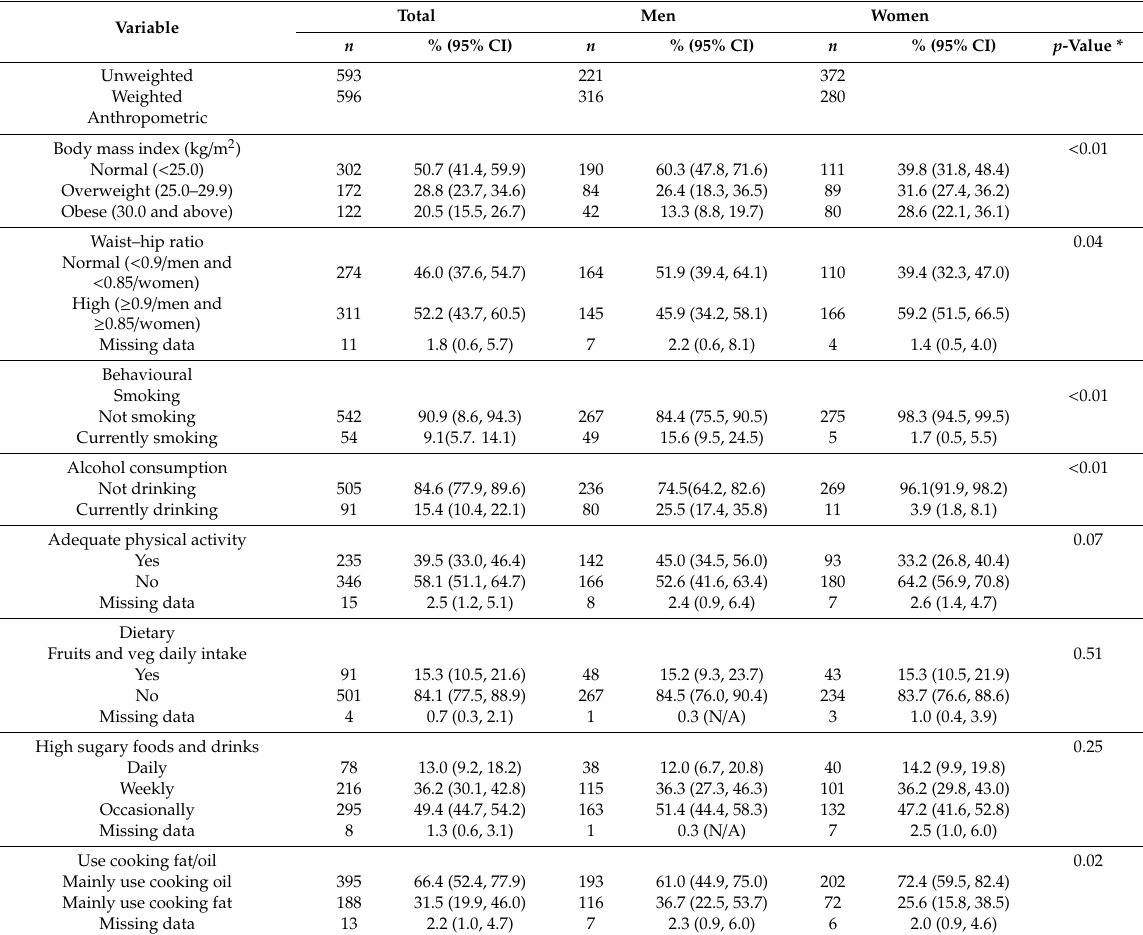
Table 3. Anthropometric, behavioural and dietary risk factors for non-communicable diseases (NCDs **) by sex among the residents of Kajiado County, Kenya ( n =